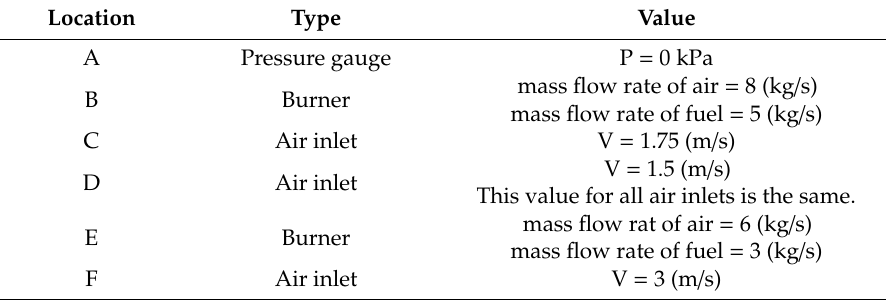
Table 4. The governing boundary condition applied in this study.